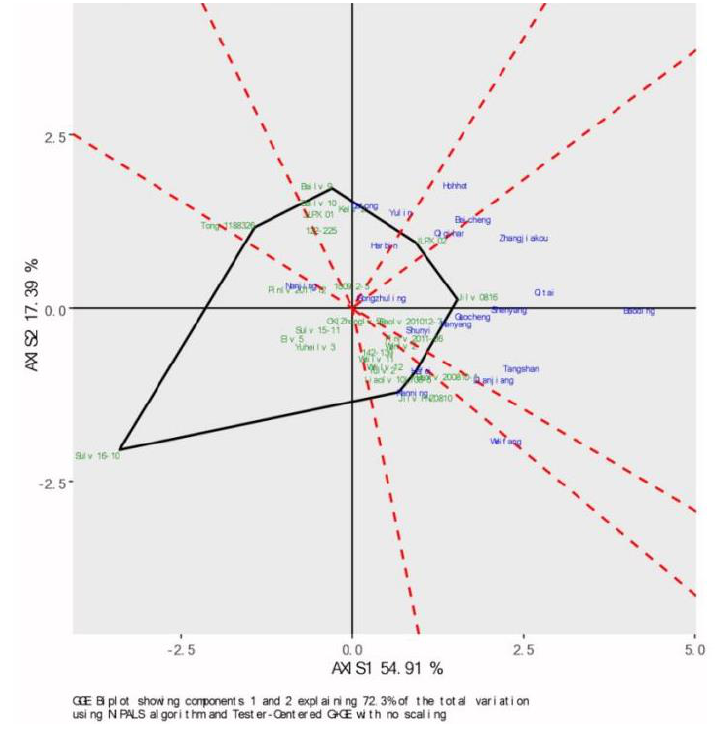
Figure 3. Yield performance of 25 varieties in multi-ecological identification